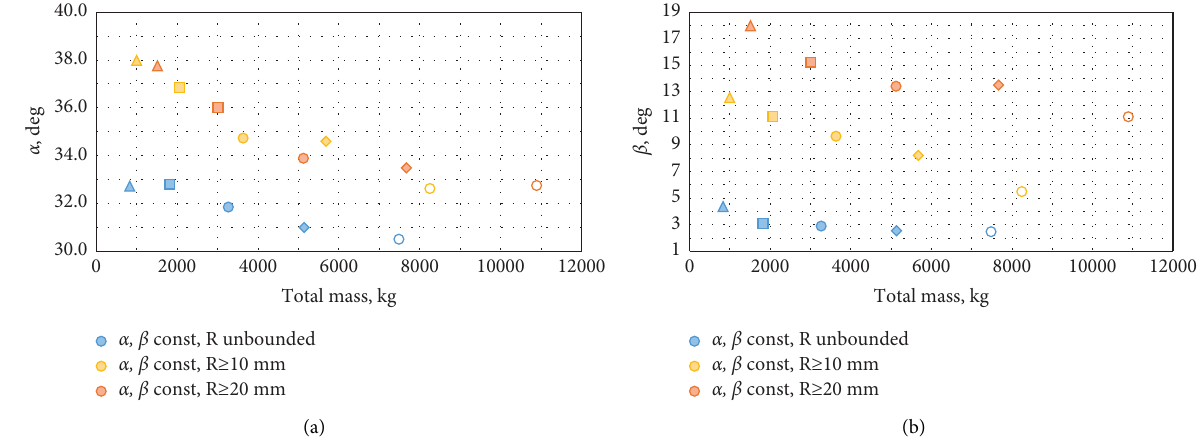
010002000300040005000